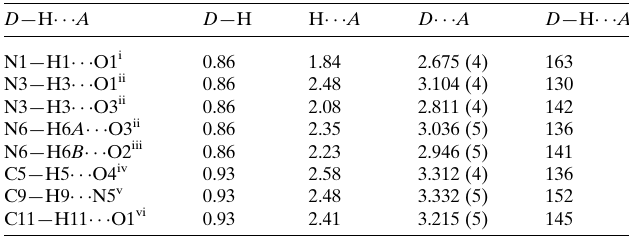
Table 1 Hydrogen-bond geometry (A˚ , (cid:5)